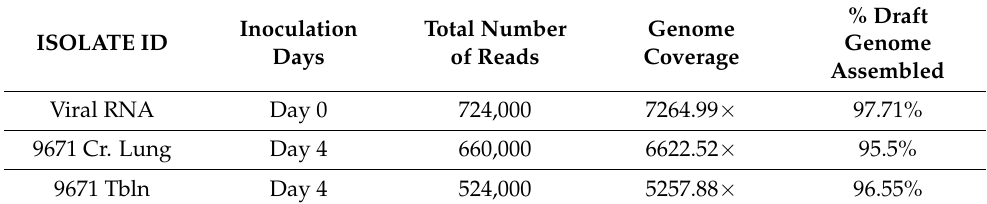
Table 2. Sequencing and Assembly Data.